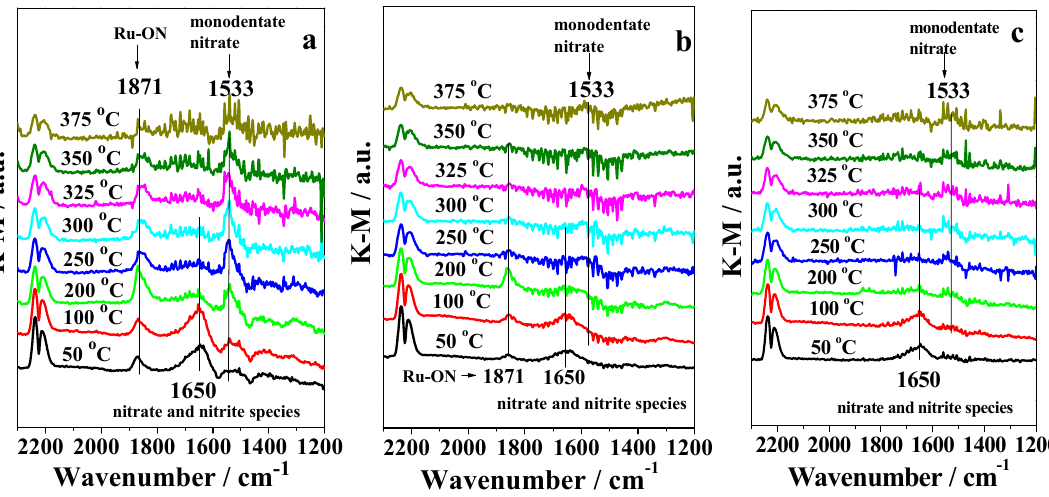
Figure 10. DRIFTS of 0.5% N 2 O during temperature ramping on: ( a ) Ru/Al 2 O 3 ‐ NaBH 4 ; DRIFTS of 0.5% N 2 O during temperature ramping on: ( a ) Ru/Al 2 O 3 -NaBH 4 ; ( b ) Ru/Al 2 O 3 ‐ H 2 ; ( c ) Ru/Al 2 O 3 ‐ air. Condition: [N 2 O] = 5000 ppm. ( b ) Ru/Al 2 O 3 -H 2 ; ( c ) Ru/Al 2 O 3 -air. Condition: [N 2 O] = 5000